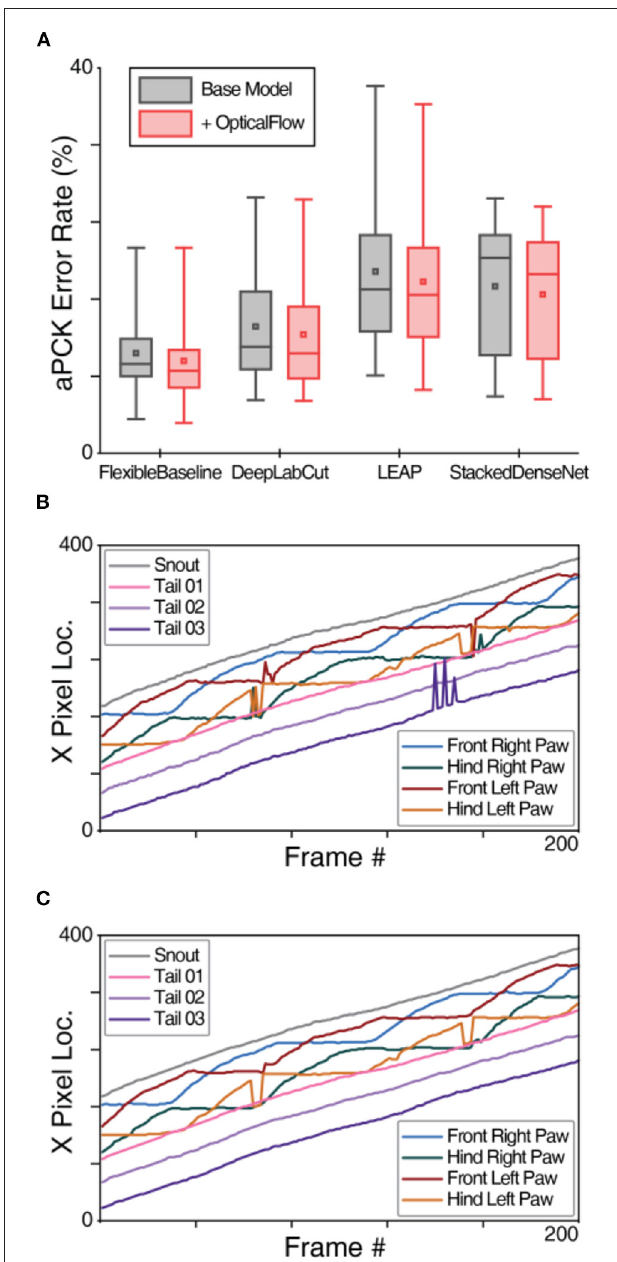
FIGURE 4 | OpticalFlow model of OptiFlex evaluation. (A) Box plot of test set prediction aPCK error rates of models with and without OpticalFlow grouped by base model. Box plot specified with minimum, first quartile, median, third quartile and maximum; the small square in each box represents the mean. The benefits of the OpticalFlow model appeared universal in that it also improved the performance of the other base models (LEAP, DeepLabCut, and StackedDenseNet). The box plots are aggregations of key point prediction error rates of a given model on the mouse side-view test set (1,051 frames from different videos with 8 labelled key points). Each data point represents the aPCK error rate of a particular model’s prediction of a specific key point on the test set of mouse side-view dataset. (B) X-value traces of FlexibleBaseline key point predictions for a mouse side-view video without OpticalFlow correction.